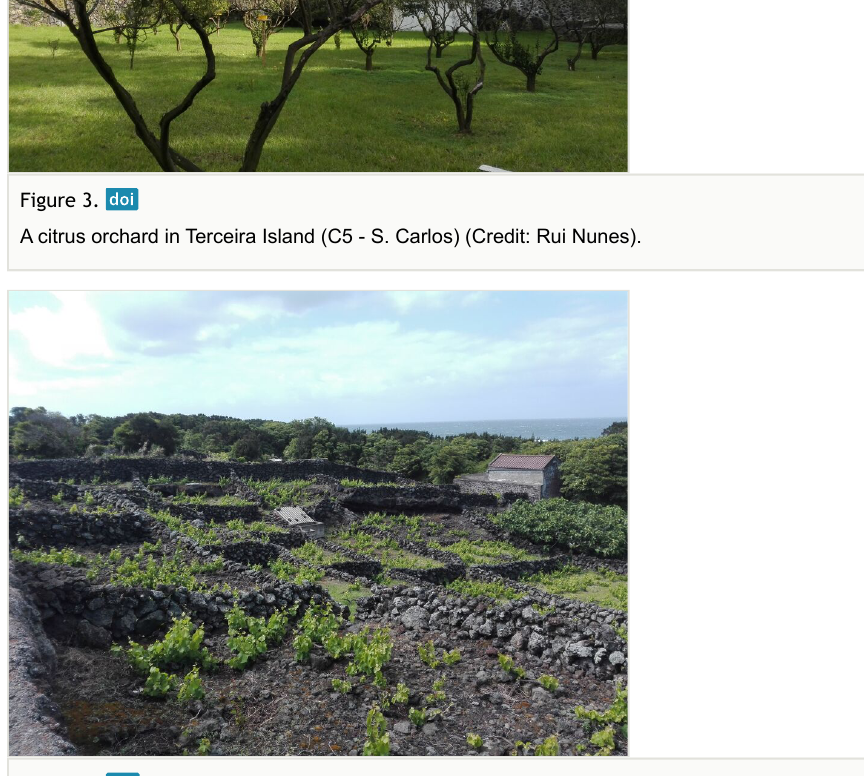
Figure 4. The vineyards in Terceira Island (V3 - Biscoitos) (Credit: Rui